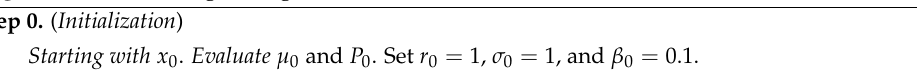
Algorithm 4 Trust-region